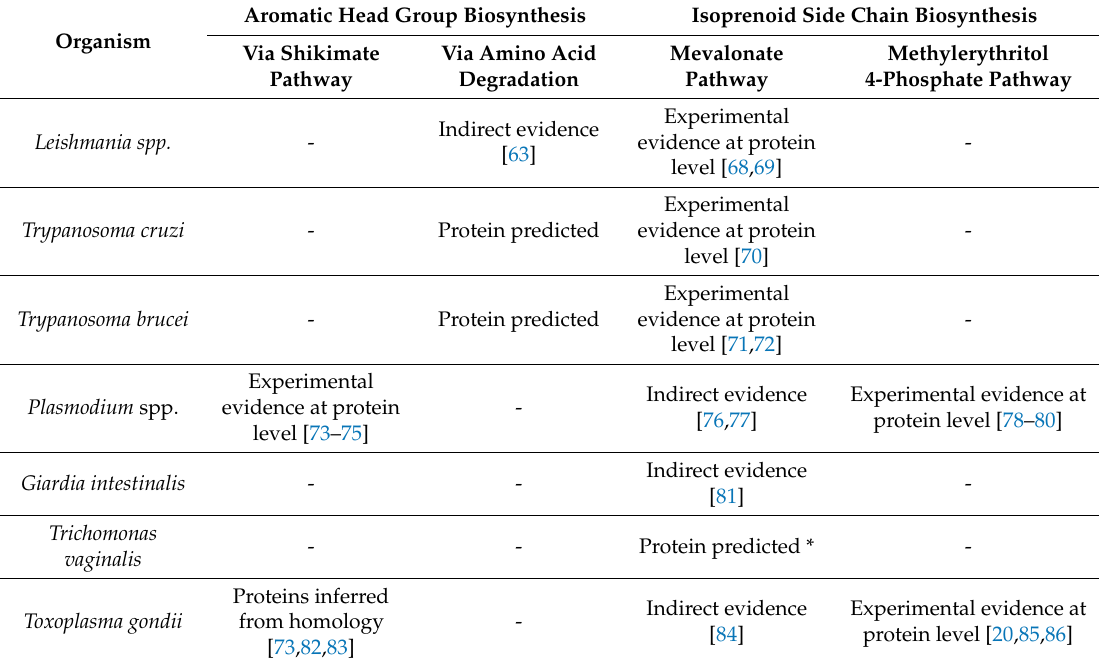
Table 2. Isoprenic / aromatic sources in pathogenic protozoa. The presence of aromatic amino acids degradation pathways (tyrosine and phenylalanine), the shikimate pathway and the isoprenoid source in pathogenic